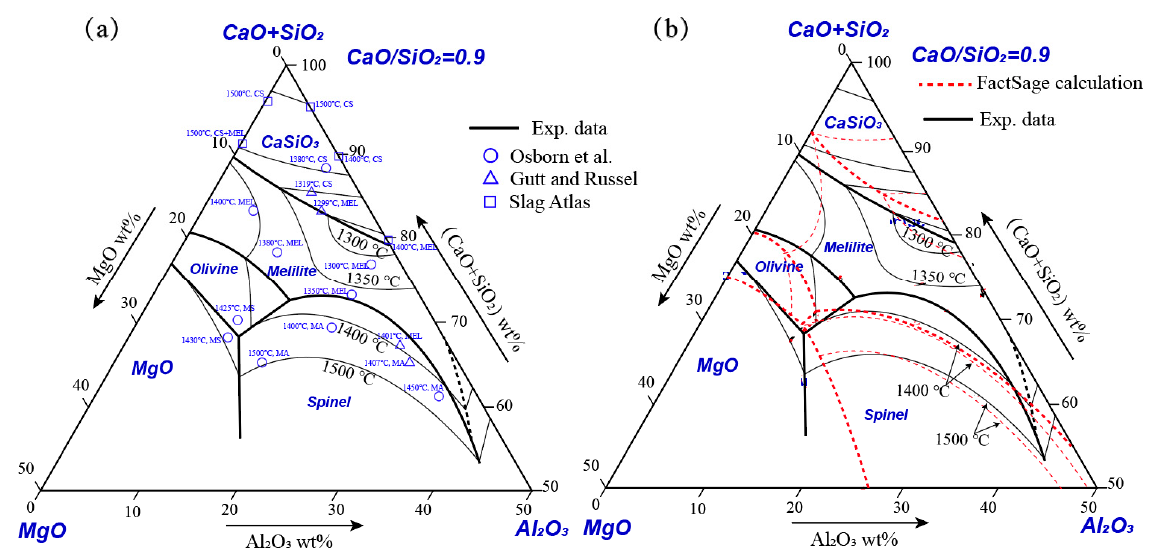
Figure 10. Experimentally determined pseudo-ternary phase diagram (CaO + SiO 2 )-Al 2 O 3 -MgO at a constant CaO/SiO 2 ratio of 0.9 [13]. ( a ) Compare with the data reported by Osborn et al. [7], Gutt and Russell [11], and Slag Atlas [25], ( b ) compare with the FactSage